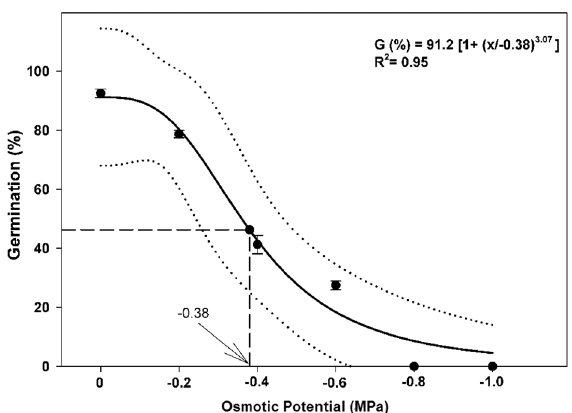
Figure 4. Influence of osmotic potential on seed germination of perennial ryegrass. Bold line represents a three-parameter logistic model (G (%) = G max /[1 + (x/x 50 ) g ]) fitted to the data. Vertical dash line represents X-axis value at 50% of the maximum germination. Dotted liens show 95% confidence intervals. Vertical bars represent ± standard error of the